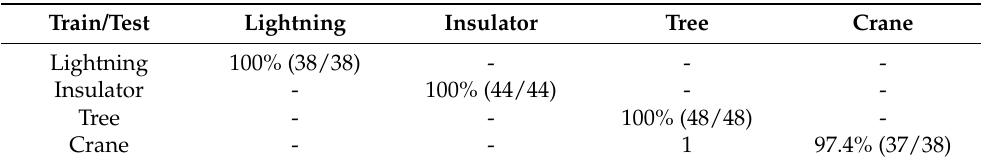
Table 11. Accuracy of the created decision tree w.r.t. all splits predictor selection on test set data for 80% training and 20% testing.